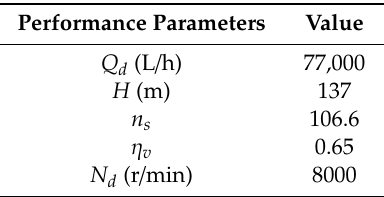
Table 1. The technical requirements under nominal operating condition.